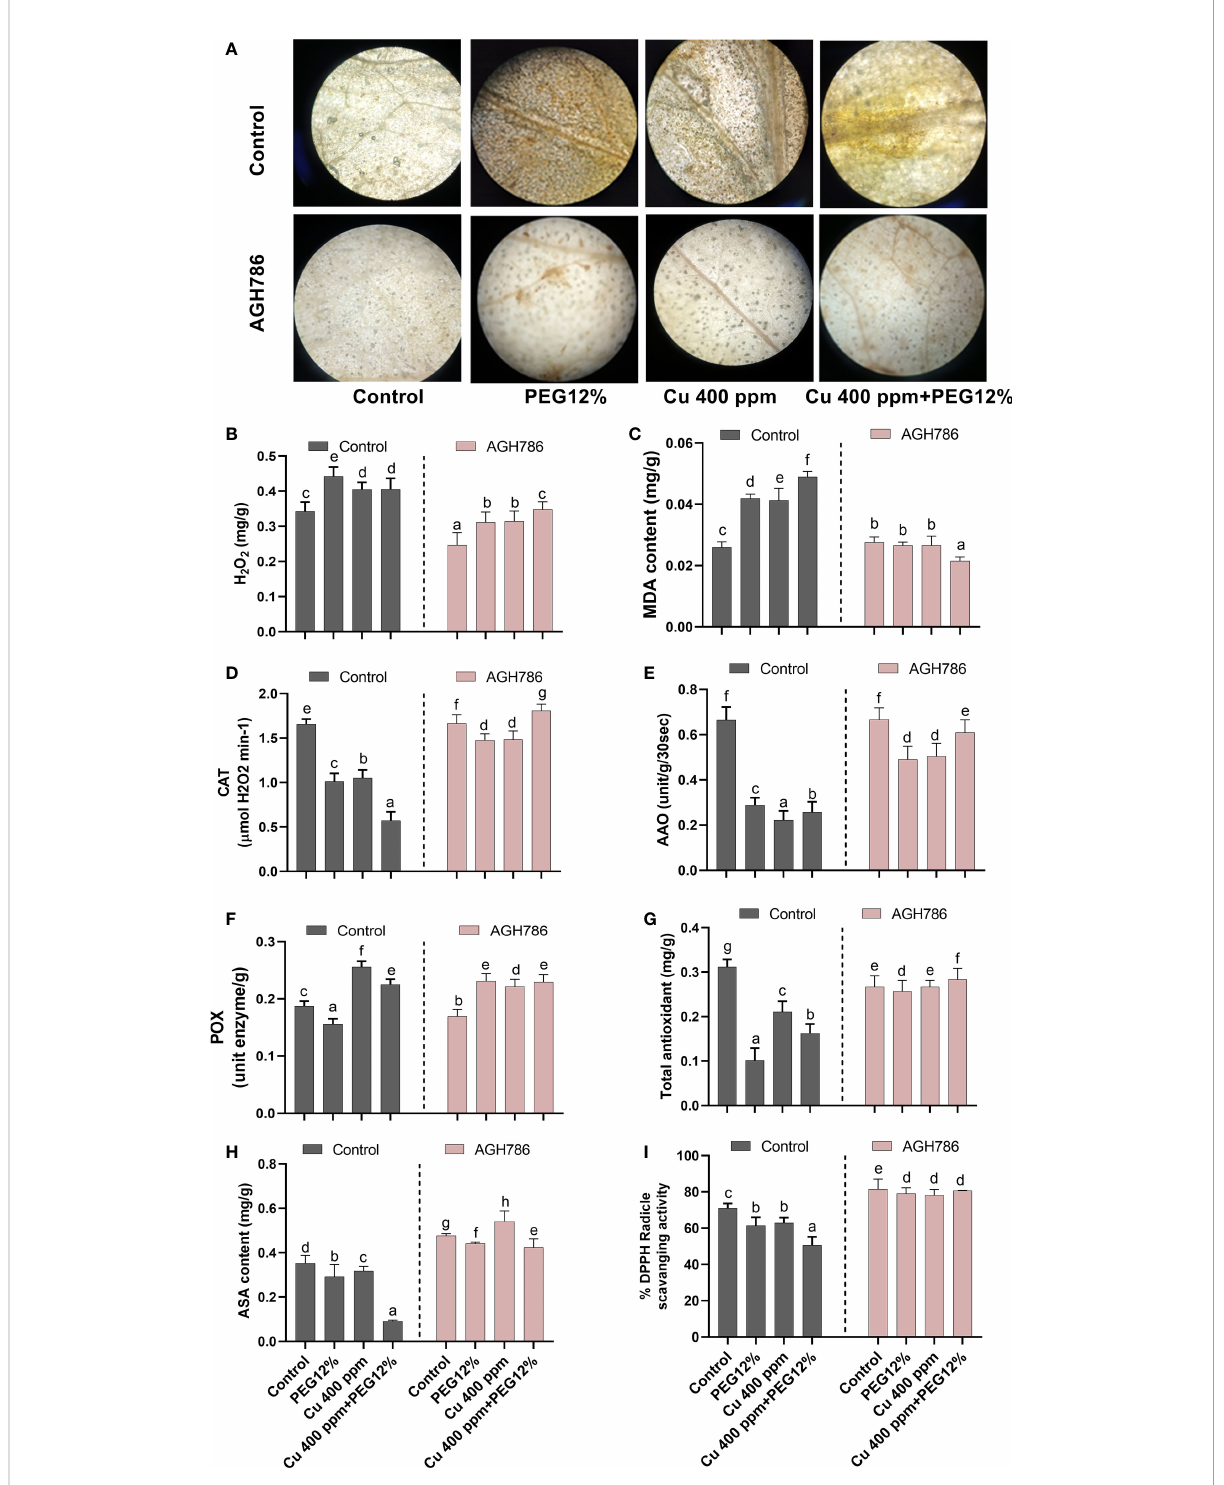
FIGURE 7 Effect of P. spadiceum AGH786 on the antioxidant potential of S. lycopersicum L. under heavy metal (Cu) toxicity and drought stress (12% PEG). (A) Effects of AGH786 on endogenous ROS accumulation. (B) H 2 O 2 level. (C) MDA content. (D) Catalase activity. (E) Ascorbate oxidase activity. (F) Peroxidase activity. (G) Total antioxidants. (H) Ascorbic acid. (I) DPPH activity. Data represent the mean with standard error, and letters represent the signi fi cant difference (p <